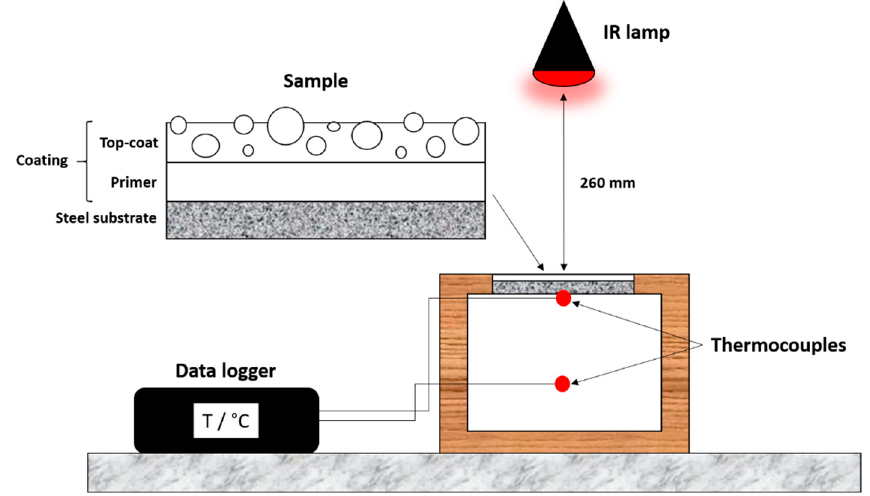
Figure 1. Experimental set-up used for the thermal behavior measurements.